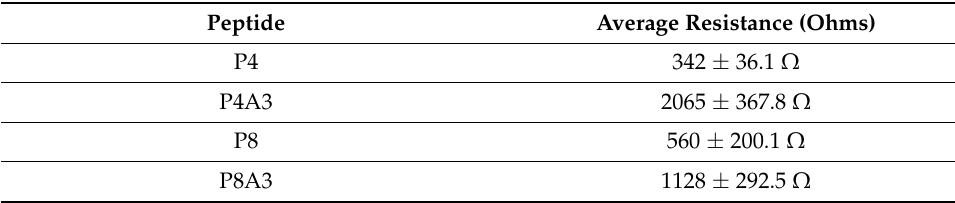
Table A3. Average resistance measurements after CNT-Peptide